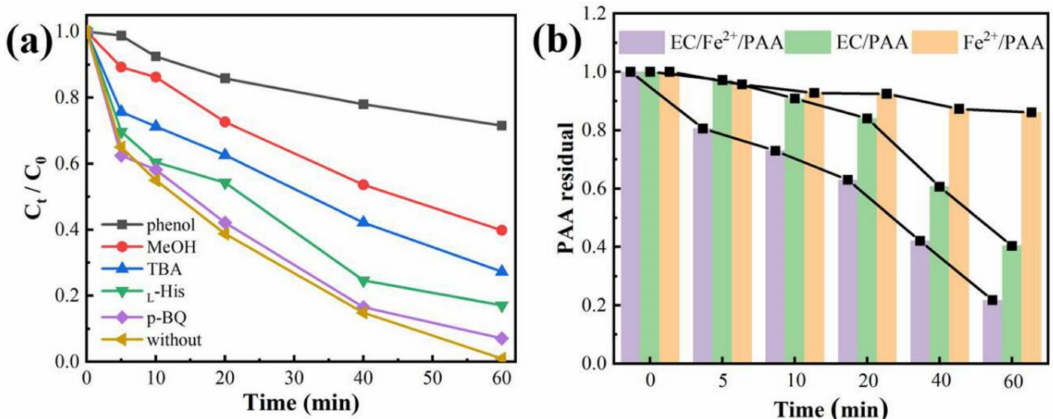
Figure 3. MB removal under various radical quenching agents in EC/Fe 2+ /PAA ( a ). Remain- ing amount of PAA under different systems ( b ). Experimental conditions: [MB] 0 = 20 mg L − 1 , [Fe 2+ ] 0 = 30 µ mol L − 1 , [PAA] 0 = 5.4 mmol L − 1 , [H 2 O 2 ] 0 = 11.25 mmol L − 1 , TBA = 6 mol L − 1 , MeOH = 10 mol L − 1 , phenol = 50 mmol L − 1 , p-BQ = 200 µ mol L − 1 , L -His = 200 µ mol L − 1 , [NaNO 3 ] = 30 mmol L − 1 , pH = 2.9, j = 15 mA cm − 2